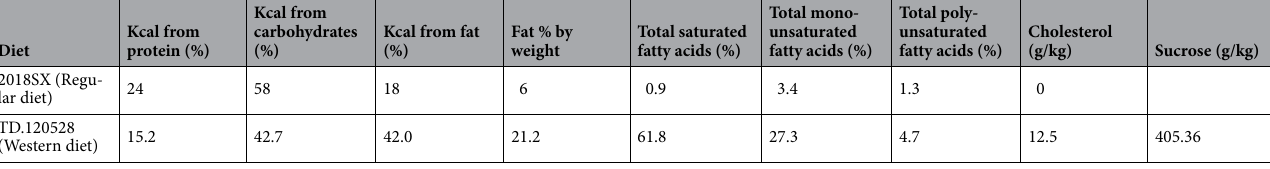
Table 1. Rodent diet